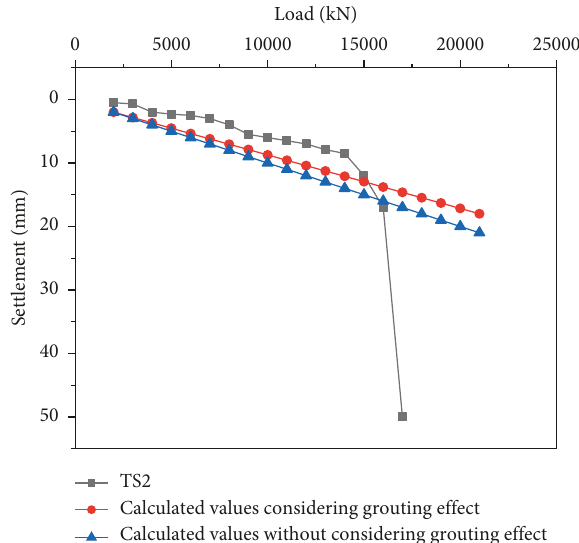
Figure 17: Comparison of actual values and calculated values of the TS2 pile